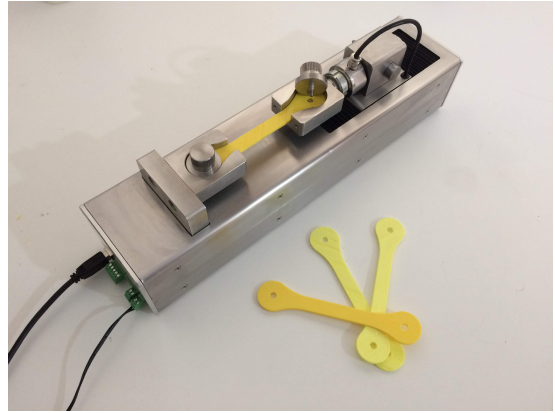
Figure 3. The MaCh3D miniaturized testing machine and MaCh3D specimen